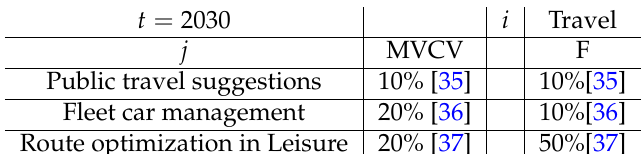
Table 10. Smart Travel saving ICT Technologies